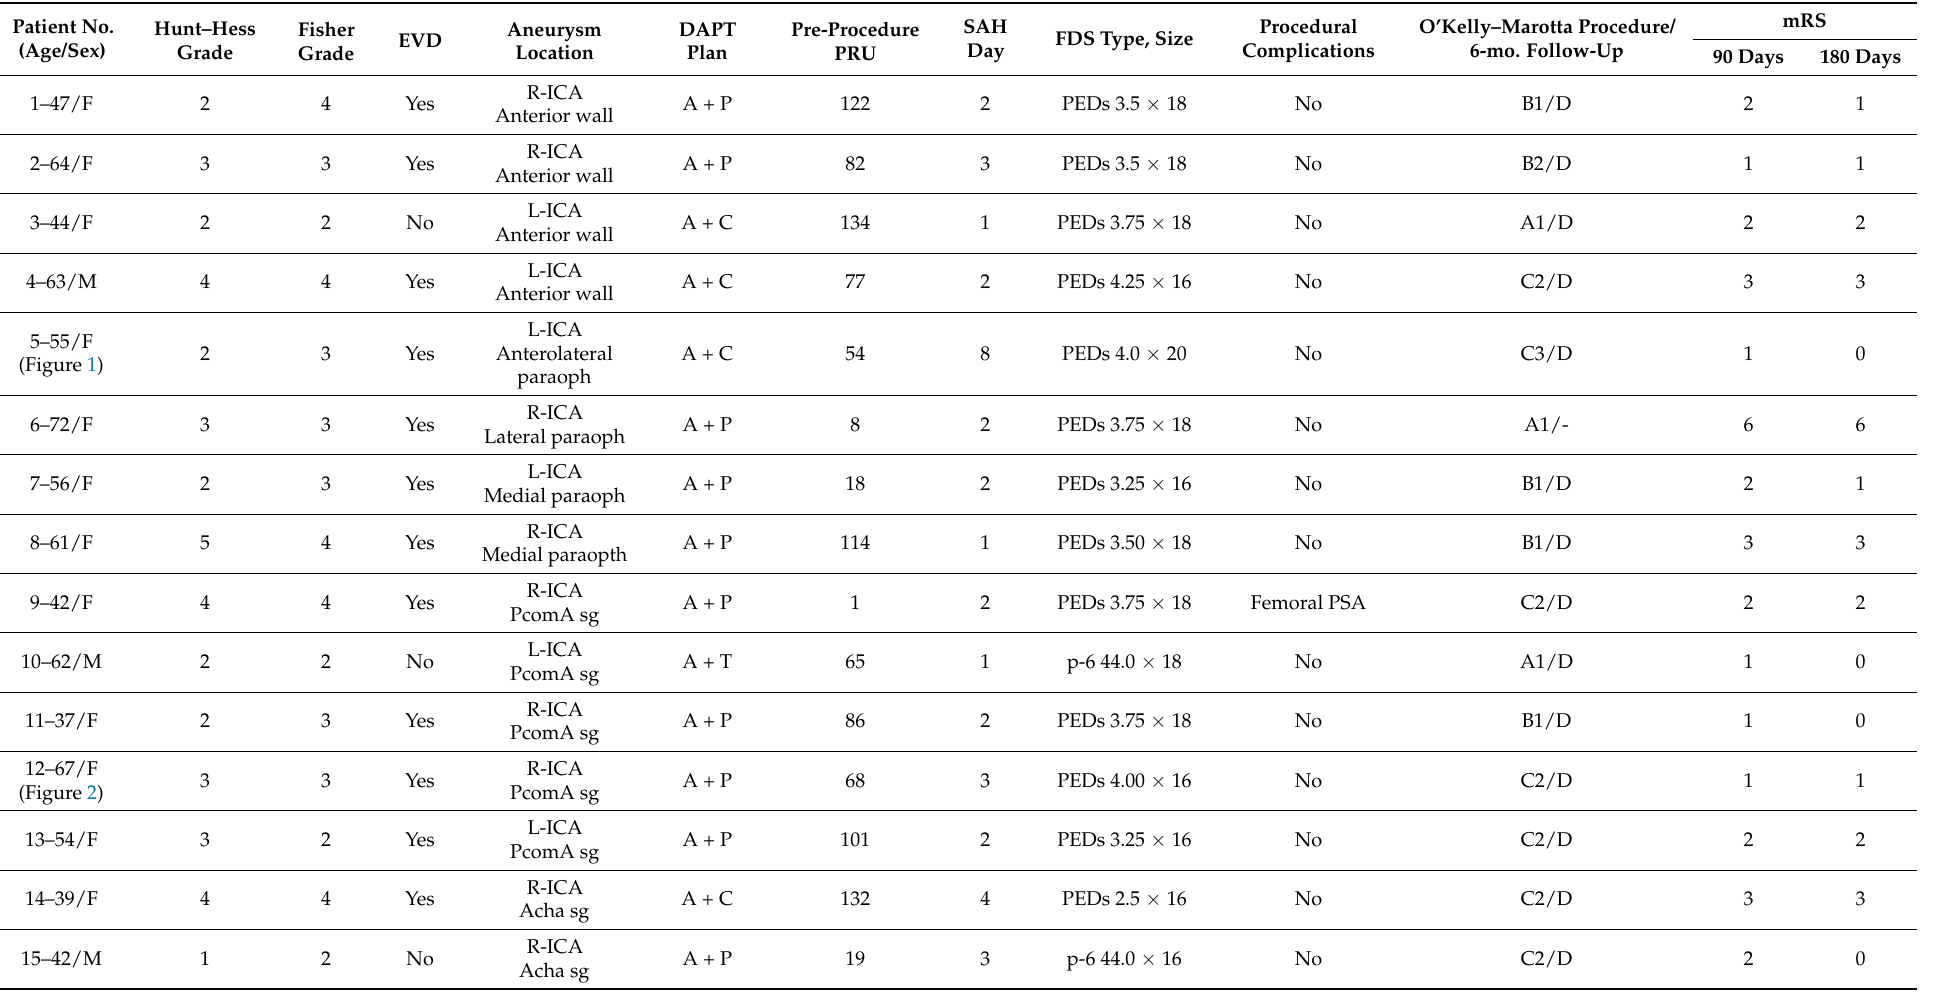
Table 1. Patient characteristics, presentation, procedural details, complications, and